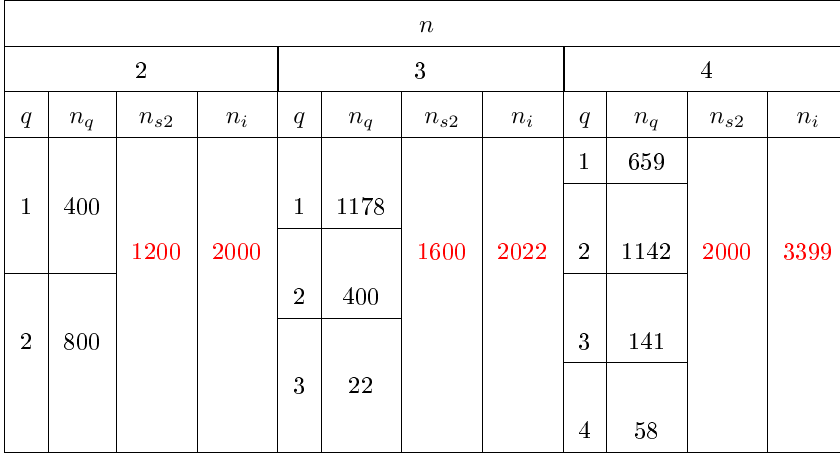
Table 7(a)-Parameters of SBT.